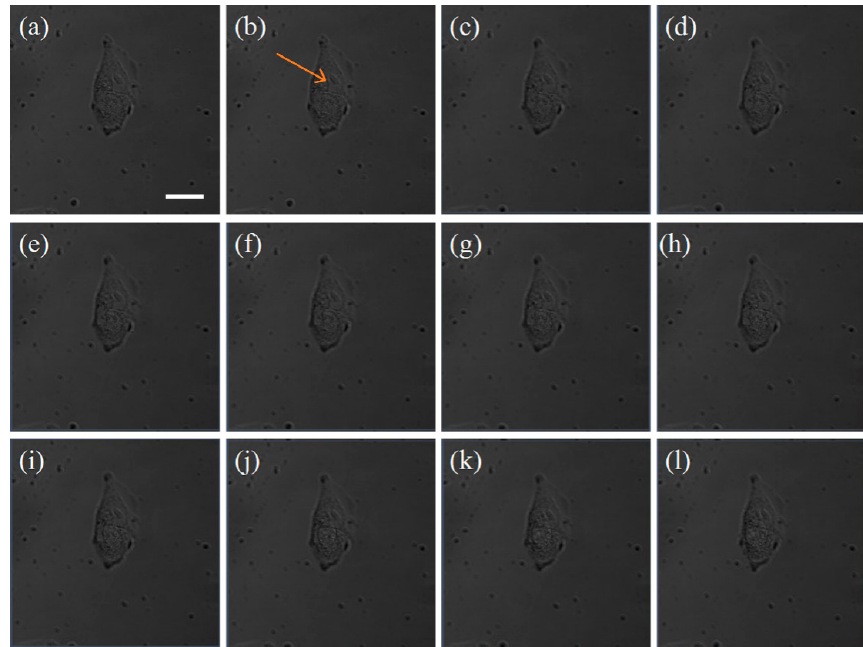
Figure 5. The image of an A375 cell not incubated with GNRs for 24 h. ( a ) The bright field image before